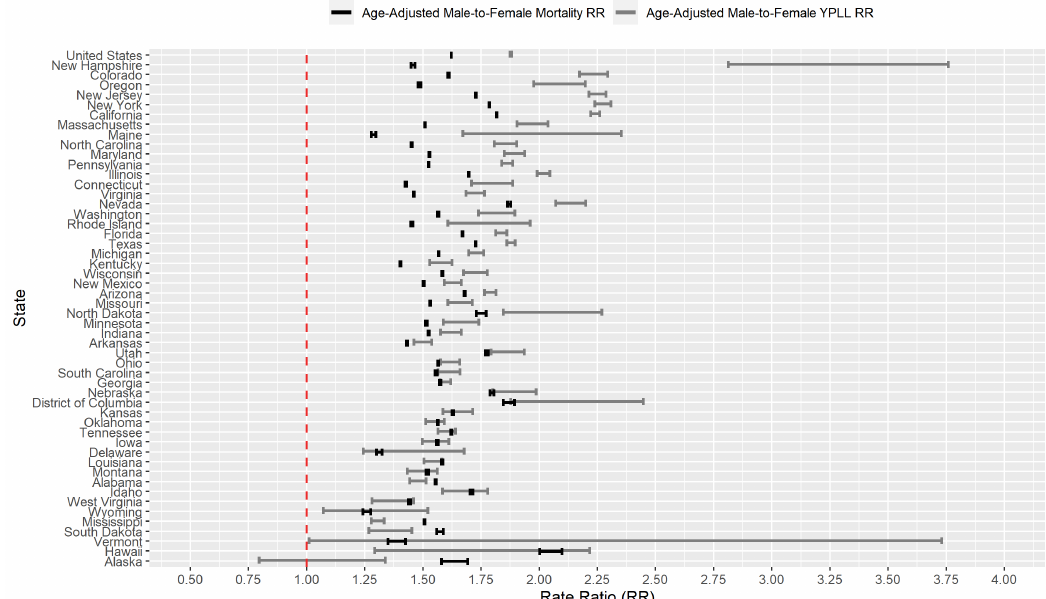
Figure 3. Conservative 95% interval estimates of the age-adjusted male-to-female YPLL and mortality RRs in the U.S. and in each of the 50 states and D.C. Quantities calculated with respect to cumulative COVID-19 deaths according to data from the National Center for Health Statistics as of 31 March 2021. States are ordered from top to bottom in descending order of the signed difference between the lower limit of the YPLL RR interval and the upper limit of the mortality RR